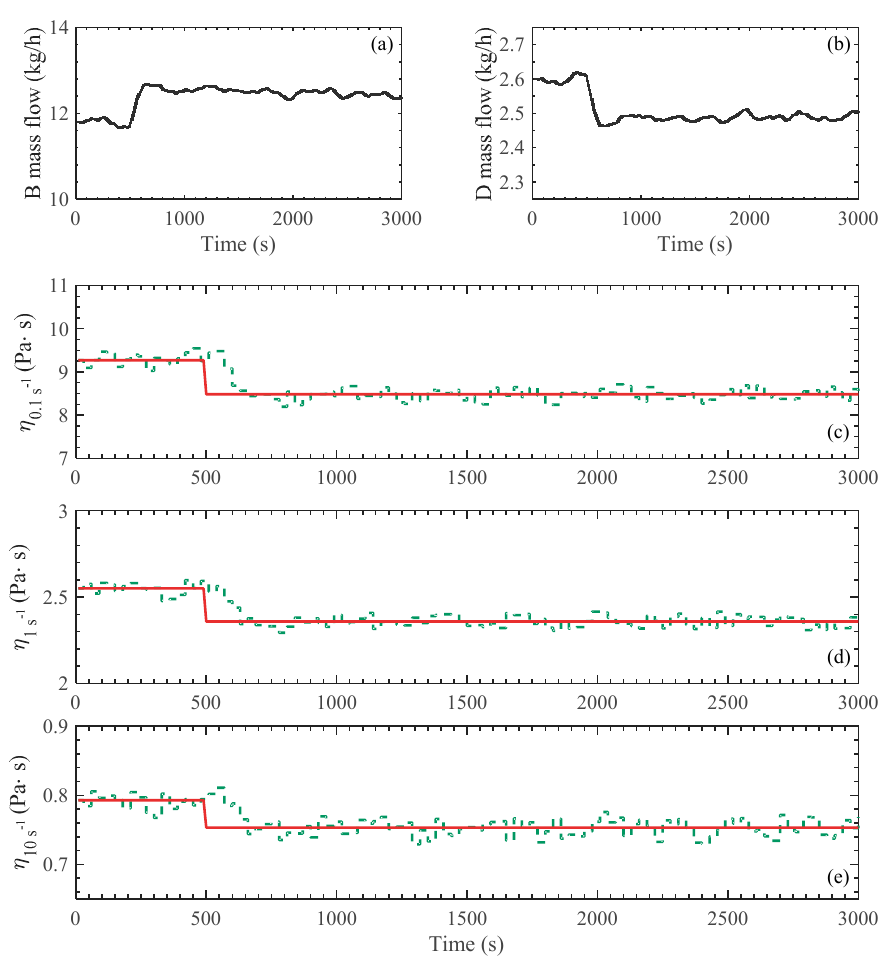
Figure 9. Performance of controller for the reference case: ( a ) mass flow of ingredient B; ( b ) mass flow of ingredient D; ( c ) response of the viscosity at shear rate equal to 0.1 s − 1 ; ( d ) response of the viscosity at shear rate equal to 1 s − 1 ; ( e ) response of the viscosity at shear rate equal to 10 s − 1 . For ( c – e ) the following data are reported: target curve (red solid line), measured value (green dashed line).